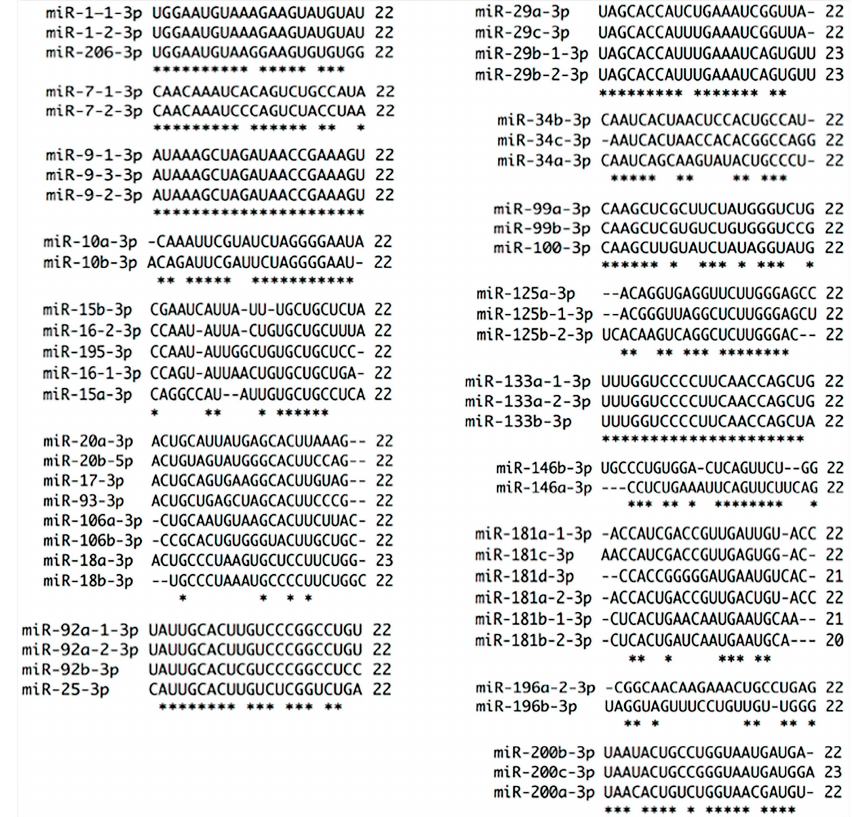
Figure 3. Alignments of miRNAs families by 3p strand selection and nt chain sizes. Sixteen miRNA families were chosen by miRNA strand and nt chain sizes. Almost all members of these families are 22 nt in length except miR-29b-1, miR-29b-2 (23 nt), miR-181b-1 (21 nt), miR-181b-2 (20 nt) and miR-200c (23 nt). Of 16 families analyzed, only five use 3p arm as guide strand. miR-1 family shares 81.81%, miR-25 family 72.72%, miR-29 family 77.27%, miR-133 family 100% and miR-200 72.72% strand conservation. The rest of the families use the strand 5p, therefore, they show less 3p strand conservation. miR-7 family has 81.81%, miR-9 family 100%, miR-10 family 77.27%, miR-15 family 45.45%, miR-34 family 54.54 %, miR-99 family 68.18%, miR-125 family 59.09%, miR-146 family 54.54% and miR-196 family 36.36% strand conservation. * at the bottom of the alignment indicates nt homology between family members.